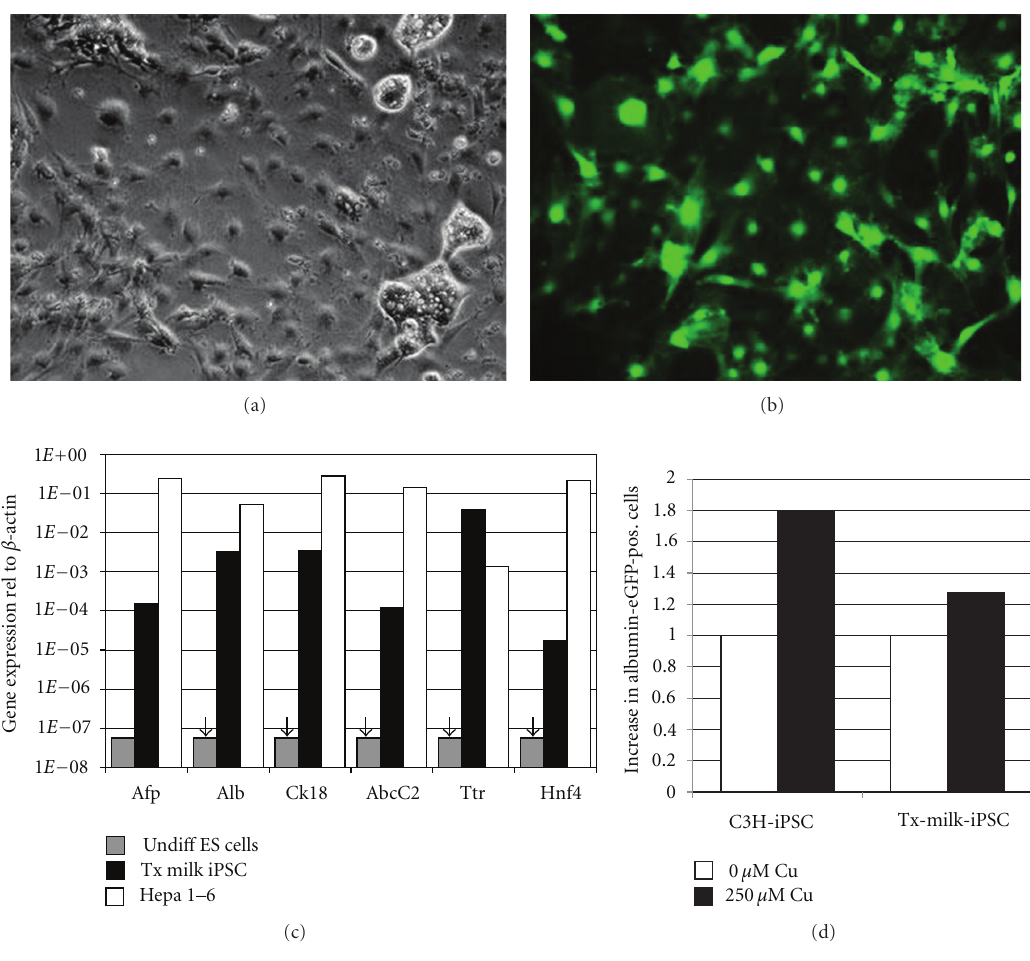
Figure 3: Hepatic di ff erentiation of toxic milk iPS cells. (a, b) Toxic-milk iPS were subjected to hepatic di ff erentiation using hanging drop method and transduced with lentiviral Alb-GFP expression vector. (c) qRT PCR analysis for hepatic marker genes Afp, Alb, Ck18, Abcc2, Ttr, and Hnf4 α . Undi ff erentiated cells served as negative control, in which no hepatic gene expression was determined until cycle 45 ( ↓ ). (d) During the last seven days of di ff erentiation, the cells were challenged with copper. The toxic-milk mice-derived cells could not export copper, and, therefore, no enrichment of Alb-positive cells was achieved. However, C3H-derived control cells were able to “detoxify” copper after hepatic specifications and, therefore, Alb-eGFP-positive cells were